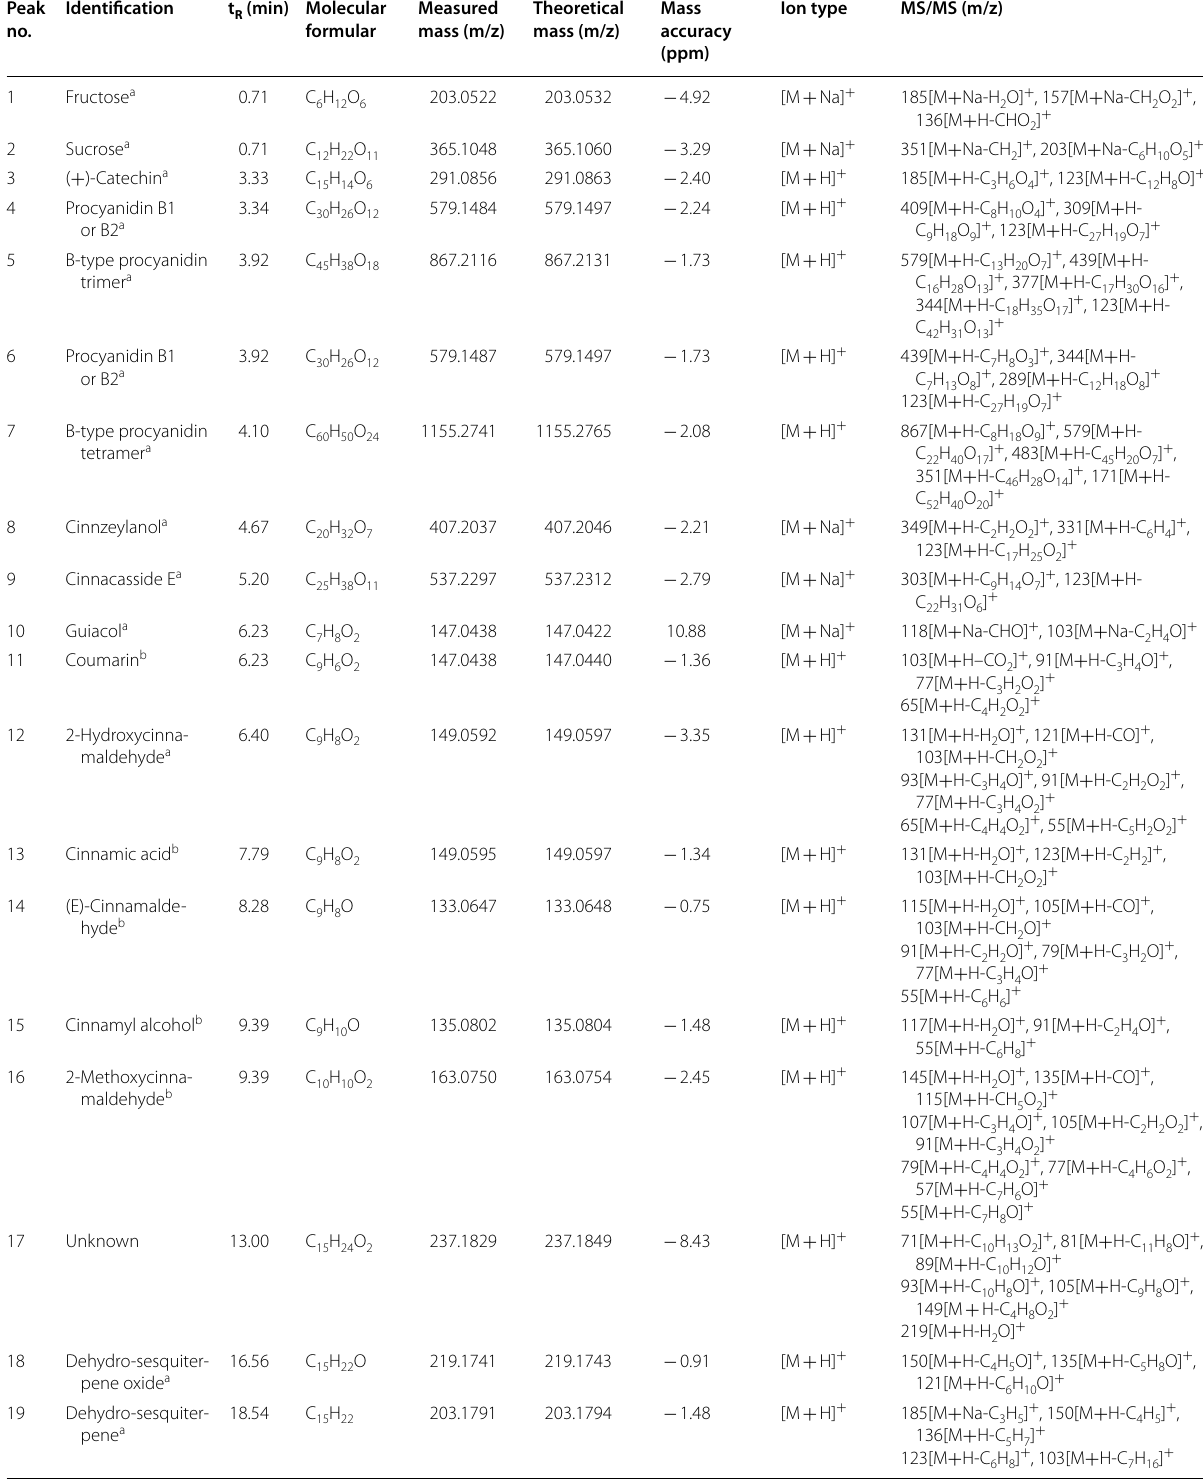
Table 2 Chemical characterization of medicinal material sample of RGyuncj by UPLC-Q/TOF–MS Peak